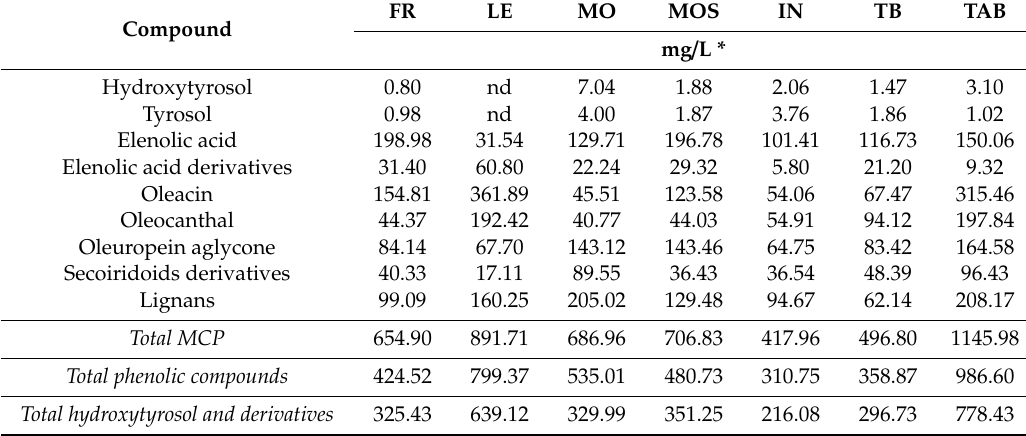
Table 3. High-Performance Liquid Chromatography (HPLC-DAD-MS) analysis of EVOOs samples. FR LE MO MOS IN TB TAB Compound mg / L *